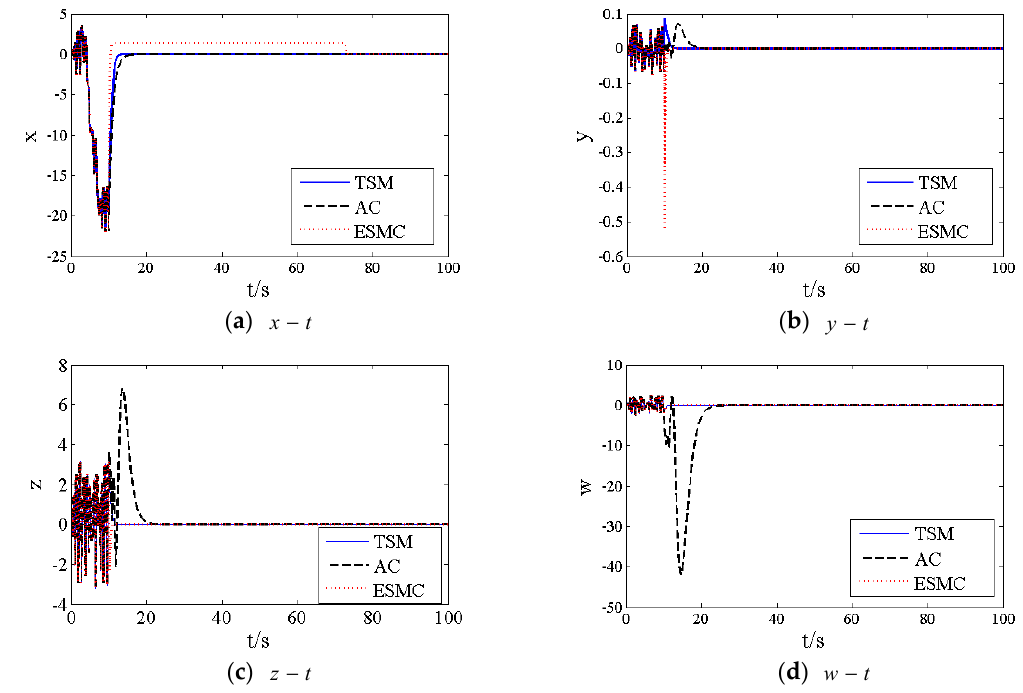
Figure 6. State responses with the controllers (40), (43), and (44). ( a ) x − t ; ( b ) y − t ; ( c ) z − t ; ( d ) w − t